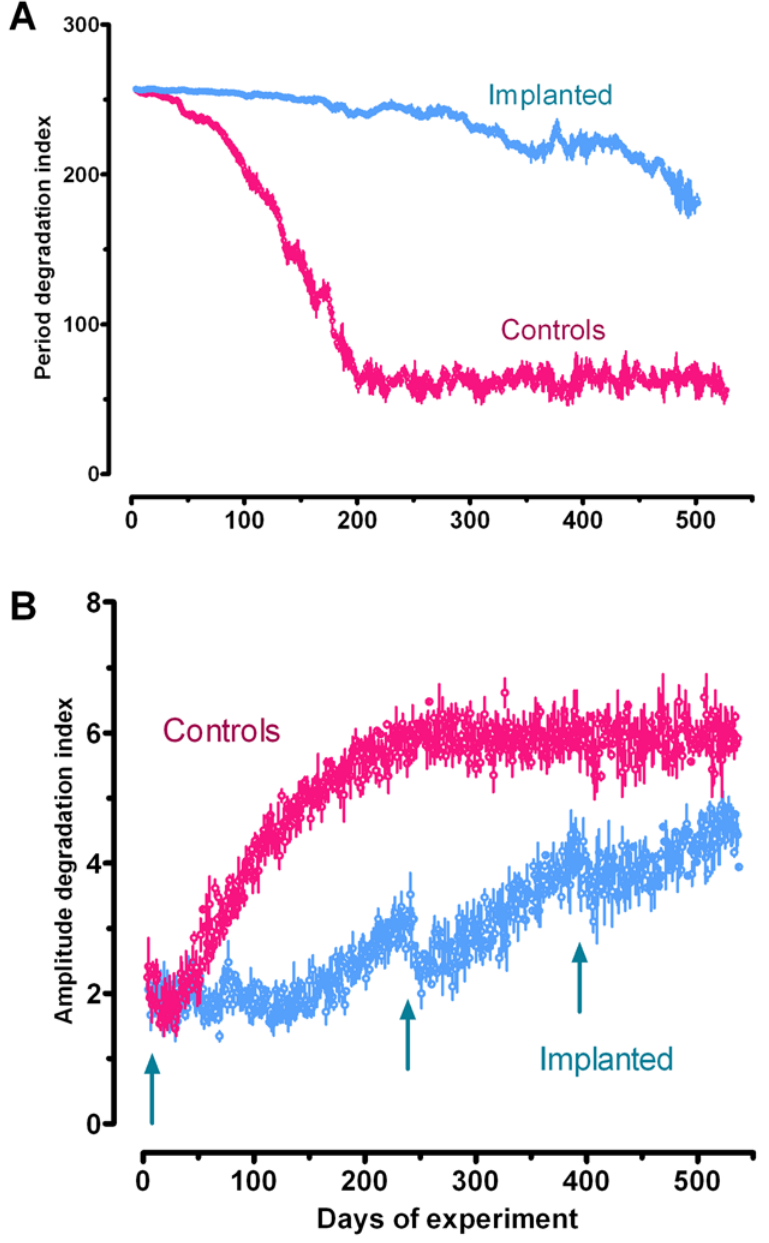
Figure 4. Period and amplitude degradation indexes over the duration of the experiment. For each individual, the 24 h period ( A ) and amplitude ( B ) degradation indexes were calculated as explained in the text, and are reported as a function of the time course of the experiment. The blue arrows indicate each time a new implant was supplied. Values were calculated from the data presented in Figure 3.